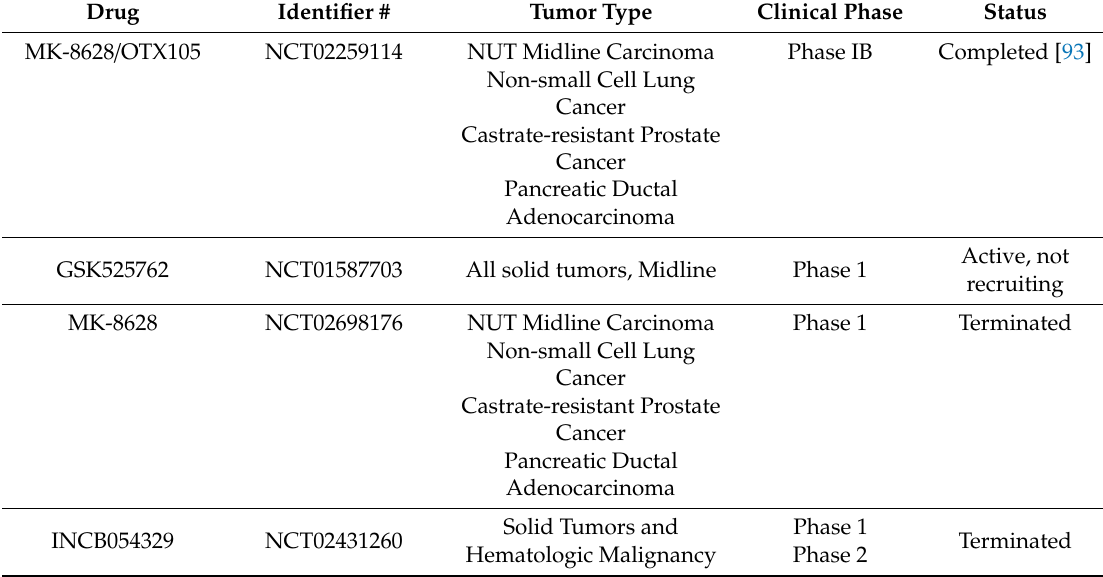
Table 1. Clinical trials with BET inhibitors on triple negative breast cancers. (# Identifier number on